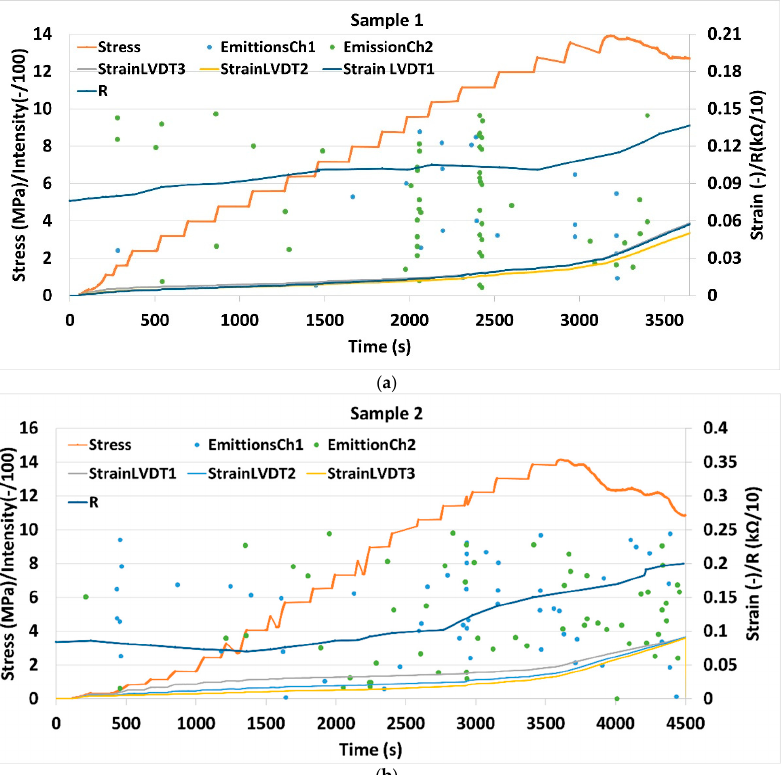
Figure 4. Stress (orange), strain measured by three different linear variable differential transformer sensors (LVDTs) (light blue, yellow, violet), resistivity (dark blue) and the intensity of acoustic emission events (blue and green dots) vs. time during uniaxial compression of specimens S1 ( a ) and S2 ( b ). with resistance, strain and stress applied to the specimens. Before the load was applied, the resistance of sample S1 was measured to be 780 Ω , while for S2, it was 840 Ω . This corresponds to a bulk resistivity of 29.6 Ω m and 31.9 Ω m for S1 and S2, respectively (for details see Materials and Methods section). Figure 3 shows good reproducibility of the results for two different specimens. A total of four different characteristic phases can be distinguished in the plot: Phase I from 0 to load up to around 2.3 MPa where resistivity is relatively constant, or even decreases and no acoustic events are registered. Phase II stretches from a stress of 2.3 MPa up to around 10 MPa. In this phase, resistivity is slowly increasing and so is the number of acoustic events. In phase III (10 ‐ 14 MPa) the number of acoustic events is significantly increasing along with material resistance. The failure of both samples occurred at around 14 MPa. At failure, the S1 and S2 resistances were 1150 Ω and 1700 Ω , respectively. The higher resistivity at failure for sample S2 coincides with the larger number of acoustic events observed in this sample. After failure, in phase IV, the resistivity and the number of acoustic events continued to increase.